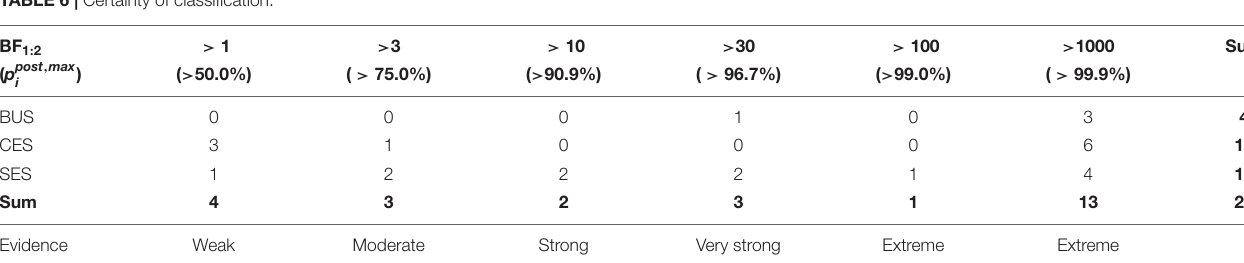
FIGURE 4 | Calculated positions of the exact strategies Bayesian update strategy (BUS), combined evidence strategy (CES), single evidence strategy (SES), and a teachers’ actual judgment J for two task–response configurations. The circles define areas of similar likelihoods in 10% percentile steps. On the left hand side, judgment J has highest likelihood for BUS; on the right hand side, it can be regarded as evidence for SES, but also for CES and less for BUS. TABLE 6 | Certainty of classification.